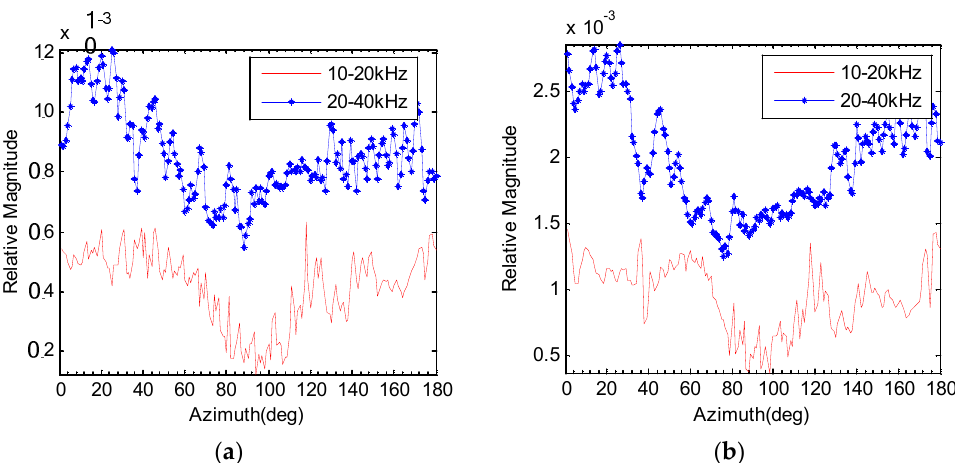
Figure 2. ( a ) Intensity of echo envelope fluctuation after normalization, the frequency is 20–40 kHz and the pulse length is 3 ms; ( b ) STD of echo envelope fluctuation after normalization.